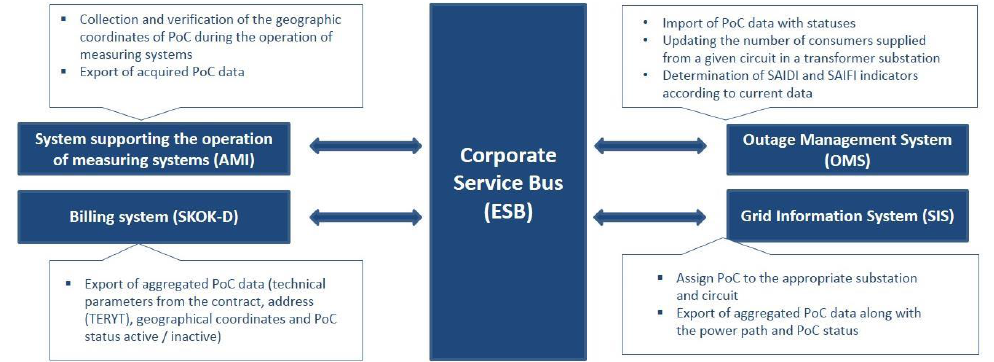
Figure 5. PoC data flow in the target solution—dynamic data update